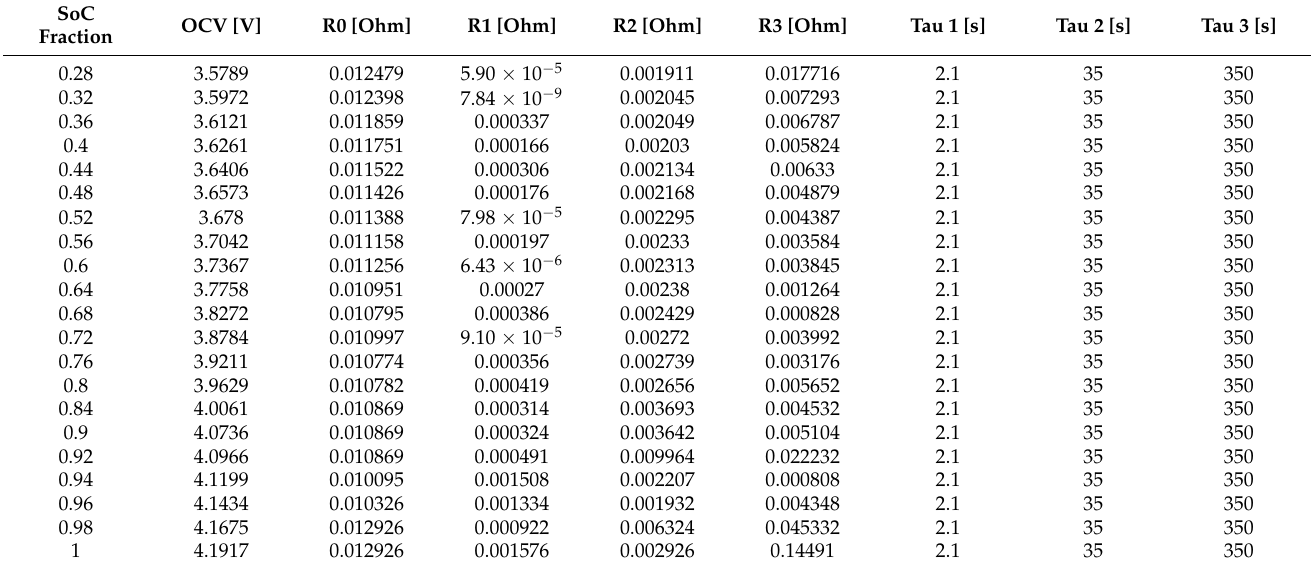
Table A5. ECM results from AMPP in the ICP at 10 ◦